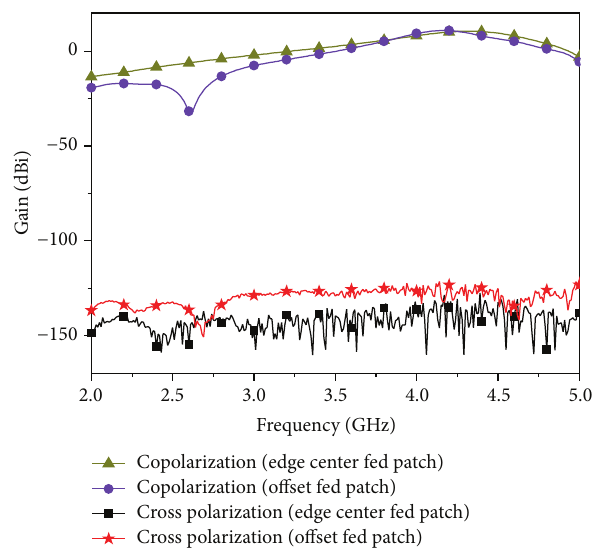
Figure 13: Gains in the main beam direction calculated by copolar- ization and cross-polarization field components of the offset fed and edge center fed patch arrays as functions of